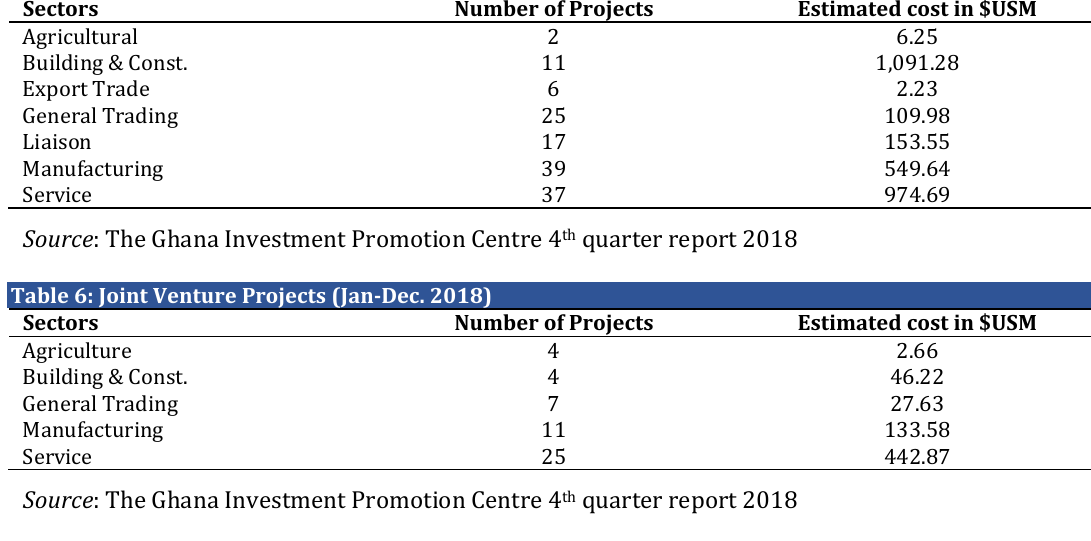
Table 5: Wholly Foreign Owned Projects (Jan-Dec. 2018)